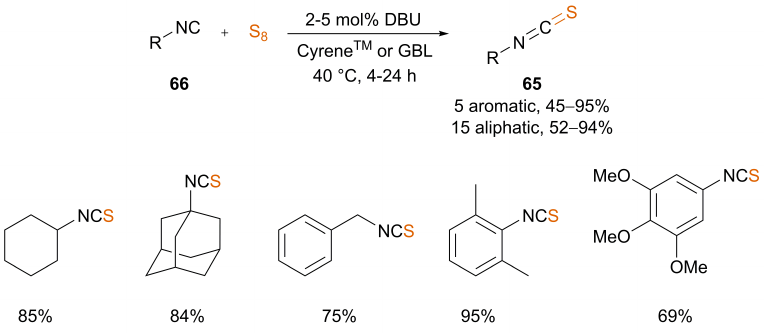
Scheme 14. Base-promoted transformation of isocyanides ( 66 ) to ITCs ( 65 ) and selected examples by Meier and co-workers ([41]). Scheme is based on Scheme 3 from